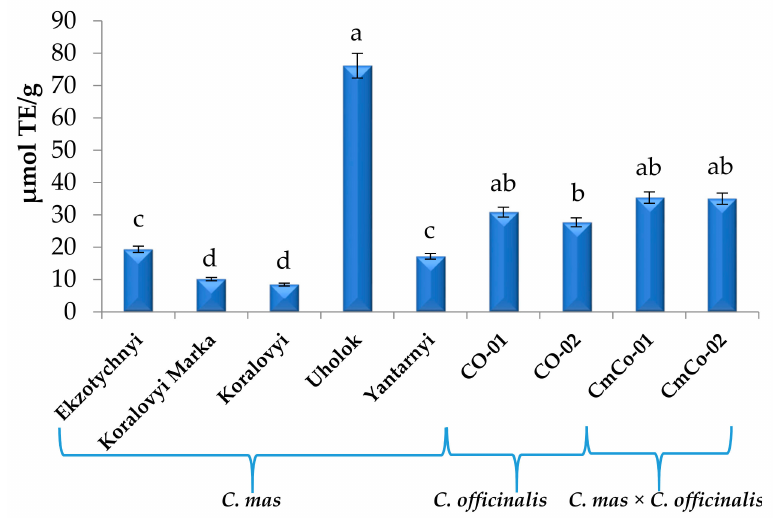
Figure 6. Antioxidant capacity of Cornus mas L., C. officinalis Siebold & Zucc., and C. mas × C. officinalis fruits extracts evaluated by FRAP method, µ mol TE/g (means in columns followed by different letters are statistically different at p ≤ 0.05). FRAP, ferric reducing antioxidant